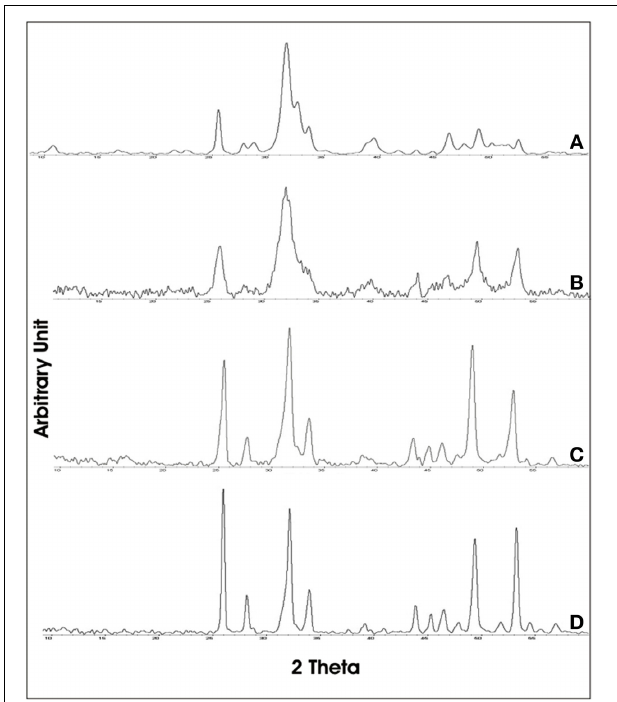
FIGURE 7 | DRX pattern of the enamel after the in vivo treatment using the following. (A) synthetic biomimetic CHA nanostructured microclusters,